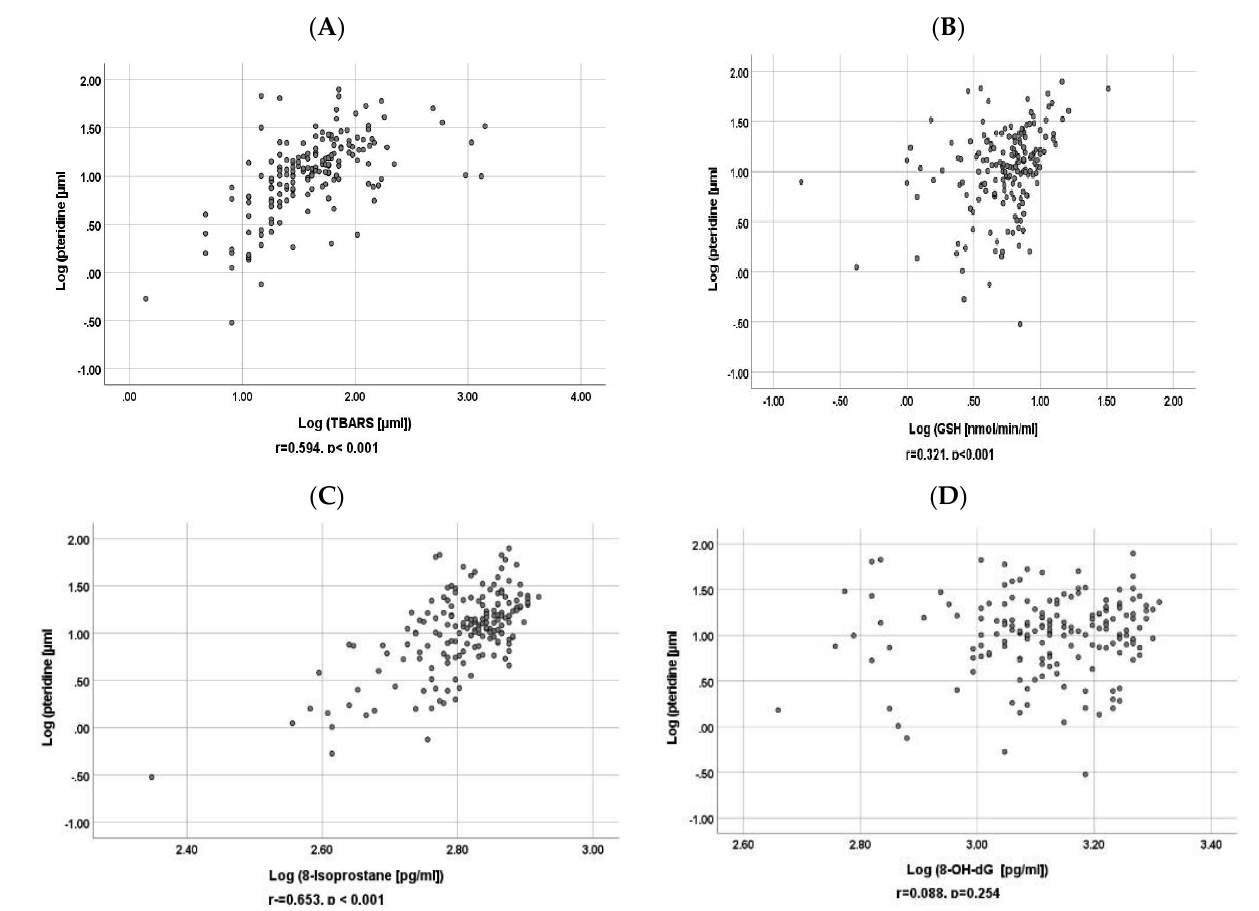
Figure 3. Scatter plots for correlations of log-transformed follow up urinary pteridine with log trans- formed follow up ( A ) urinary TBARS, ( B ) GSH, ( C ) 8-isoprostane, and ( D ) 8-OH-dG. Table 2 shows that, in multiple regression analysis, log-transformed urinary pteri- dine levels were significantly correlated with log-transformed urinary GSH, 8-isopros- tane, and TBARS after adjusting for urinary creatinine both at baseline and follow-up ( p < 0.05). Table 2. Correlation of (A) baseline and (B) follow-up urinary pteridine with urinary GSH, 8-iso- prostane, 8-OH-dG, and TBARS in multiple regression analysis.